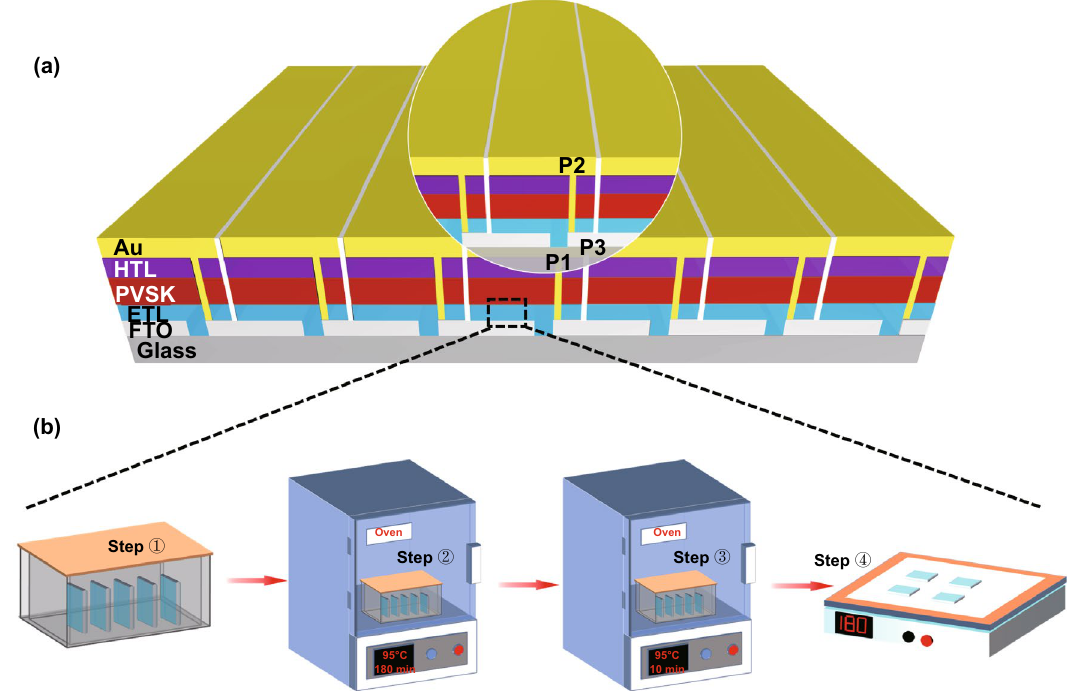
Fig. 1 a Illustration of perovskite solar module architecture (ETL/HTL is electron/hole transport layer. PVSK is the perovskite layer.). b Sche- matic illustration of the